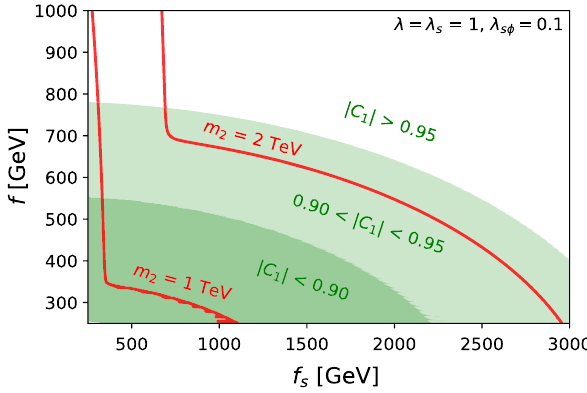
Fig. 1 C 1 contoursinthe ( f s , f ) plane,for λ = λ s = 1and λ s φ = 0 . 1. The dark green region corresponds to | C 1 | < 0 . 90, while the light green one to 0 . 90 < | C 1 | < 0 . 95. In the white region | C 1 | > 0 . 95. The two red curves correspond to values for the next to lightest scalar m 2 = 1 TeV and m 2 = 2 TeV respectively, being the Higgs mass fixed to the reference value m h = 125 GeV | C | > 0 . 95. From this plot one can have an order of 1